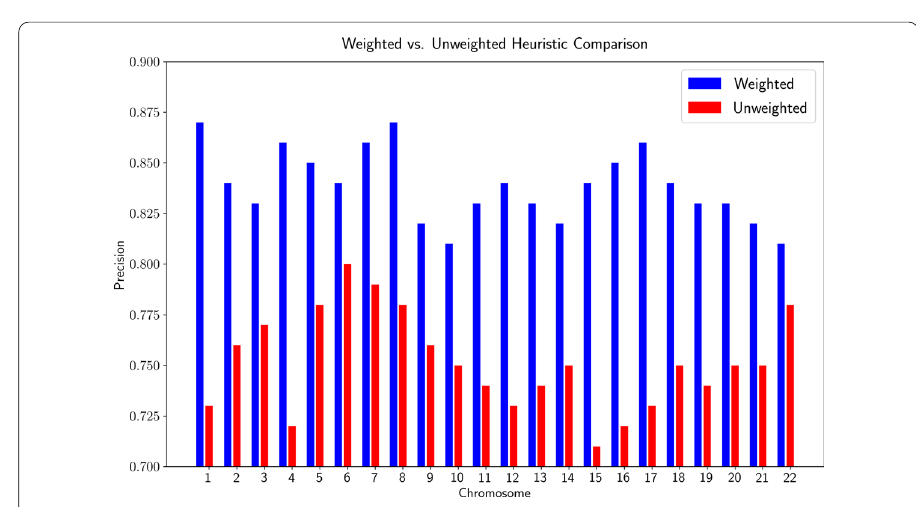
Fig. 5 The impact of weighting heuristic (Eq. 6) in precision on human ES cells across